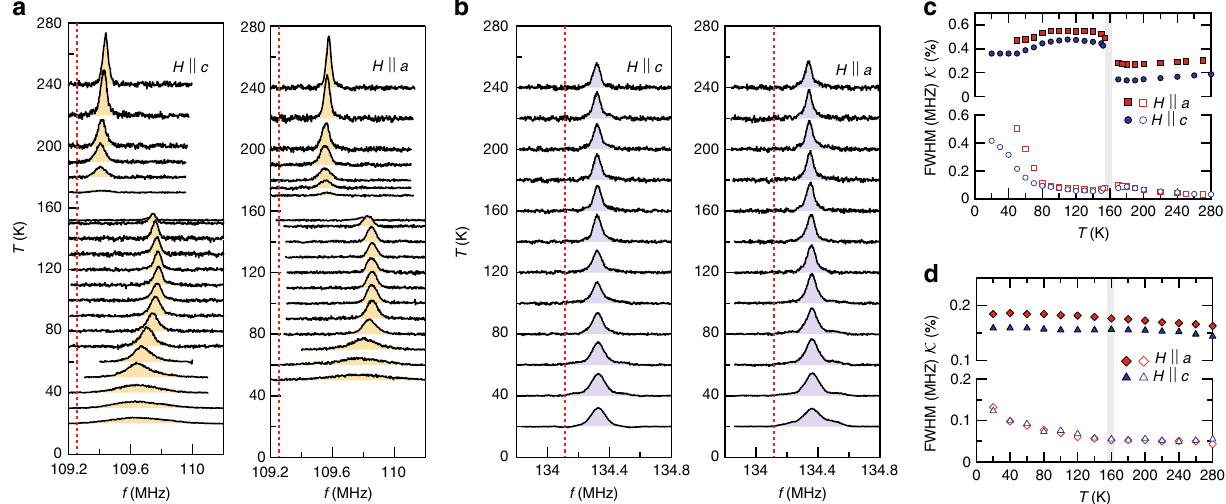
Fig. 2 NMR spectra and their analysis for the Sr 2 VO 3 FeAs single crystal. 75 As ( a ) and 51 V ( b ) NMR spectra as a function of temperature, measured at H = 15 and 12 T, respectively, for the fi elds oriented along the a and c axes. The unshifted Larmor frequency ( ν 0 ≡ γ n H ) is marked by the red vertical lines. While the 51 V spectrum is nearly temperature independent down to 20 K, the 75 As spectra in both fi eld directions show a sudden shift at T 0 ~ 155 K. c , d Temperature dependences of the 75 As and 51 V spectra in terms of the Knight shift ( K ) and the full-width at half-maximum (FWHM), respectively. Below 75 As Knight shift takes place without any magnetic line broadening, contrasting with the 51 V spectra that remain T 0 , a nearly isotropic large jump of the